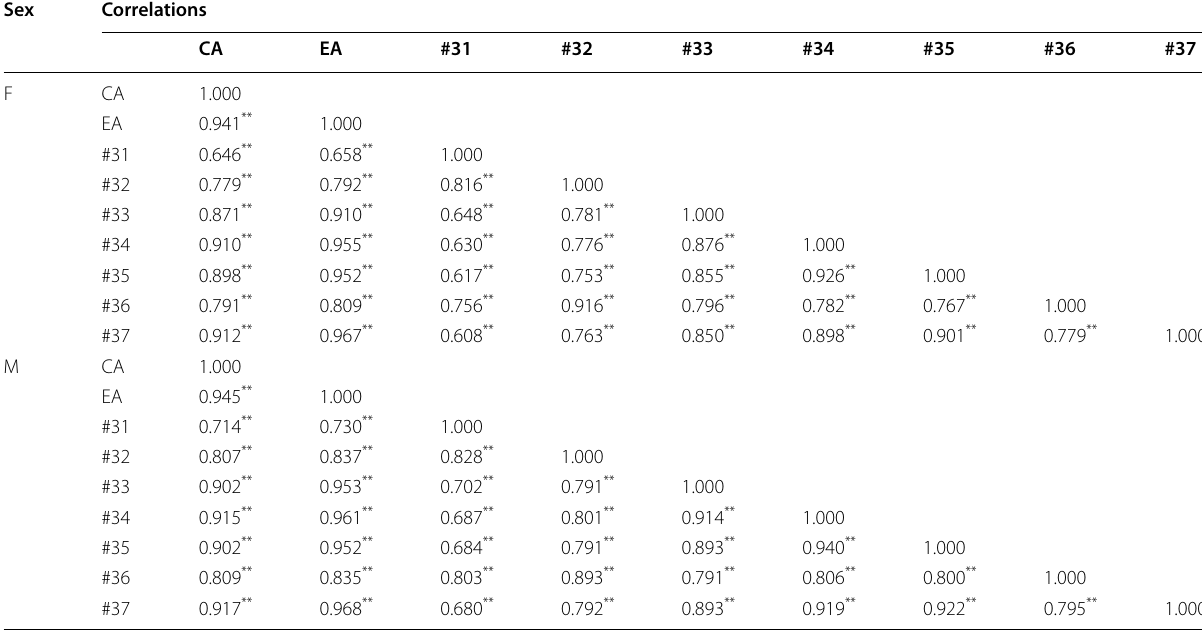
F females, M males, CA chronological age, EA estimated